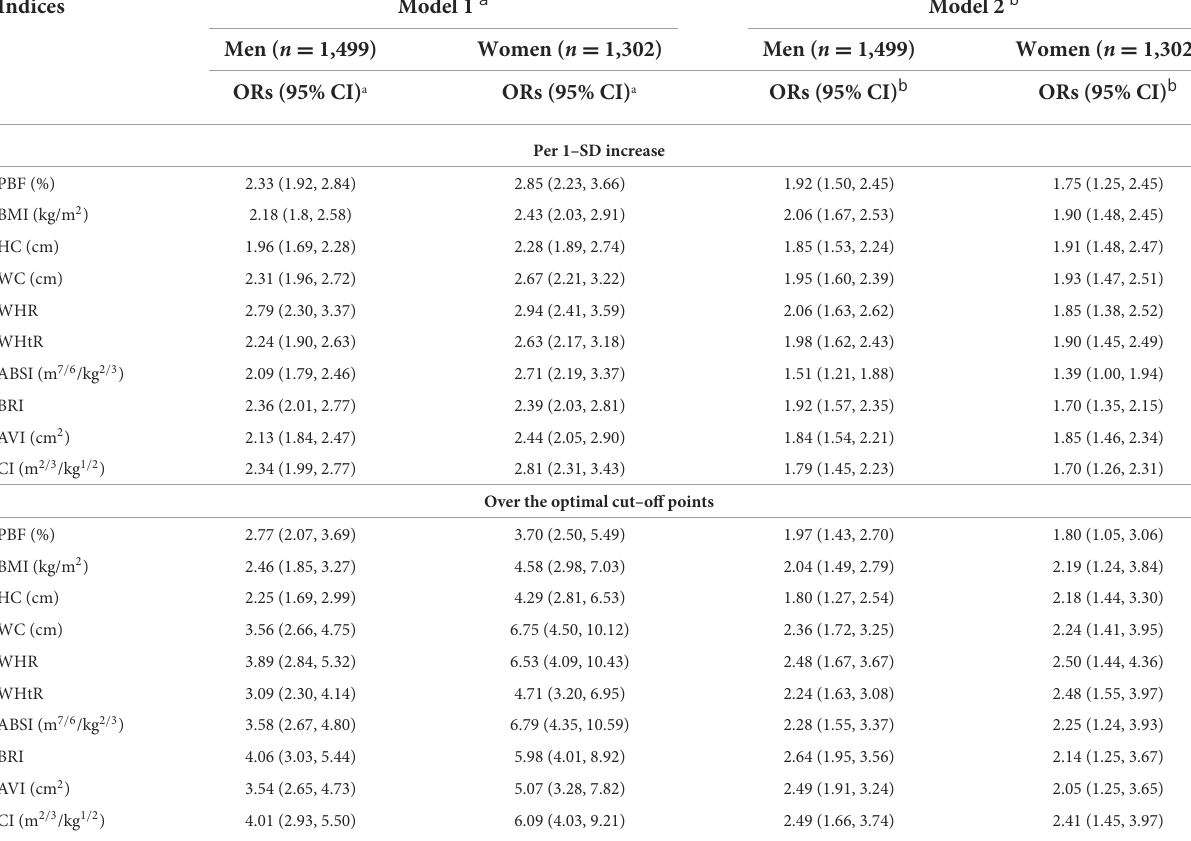
TABLE 6 Crude and adjusted ORs (per 1–SD increase and over the optimal cut–off points) of 10 types of ORI in multivariate logistic regression models.